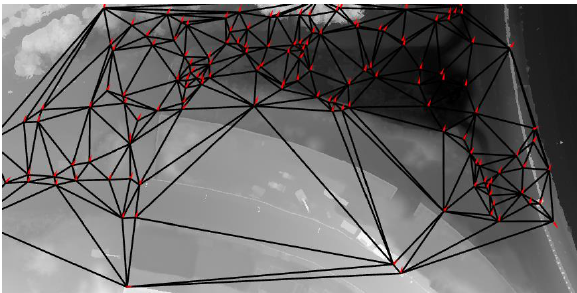
Figure 6. Identification of changes by the subtraction of the DEMs after global affine transformation: above half a meter change (green), and below half a meter change (red).